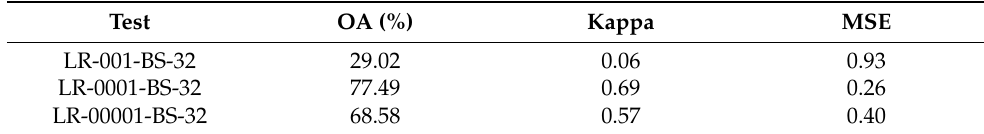
Table 5. The effects of different learning rates on model classification Table 4. The effects of different batch sizes on model classification accuracy.